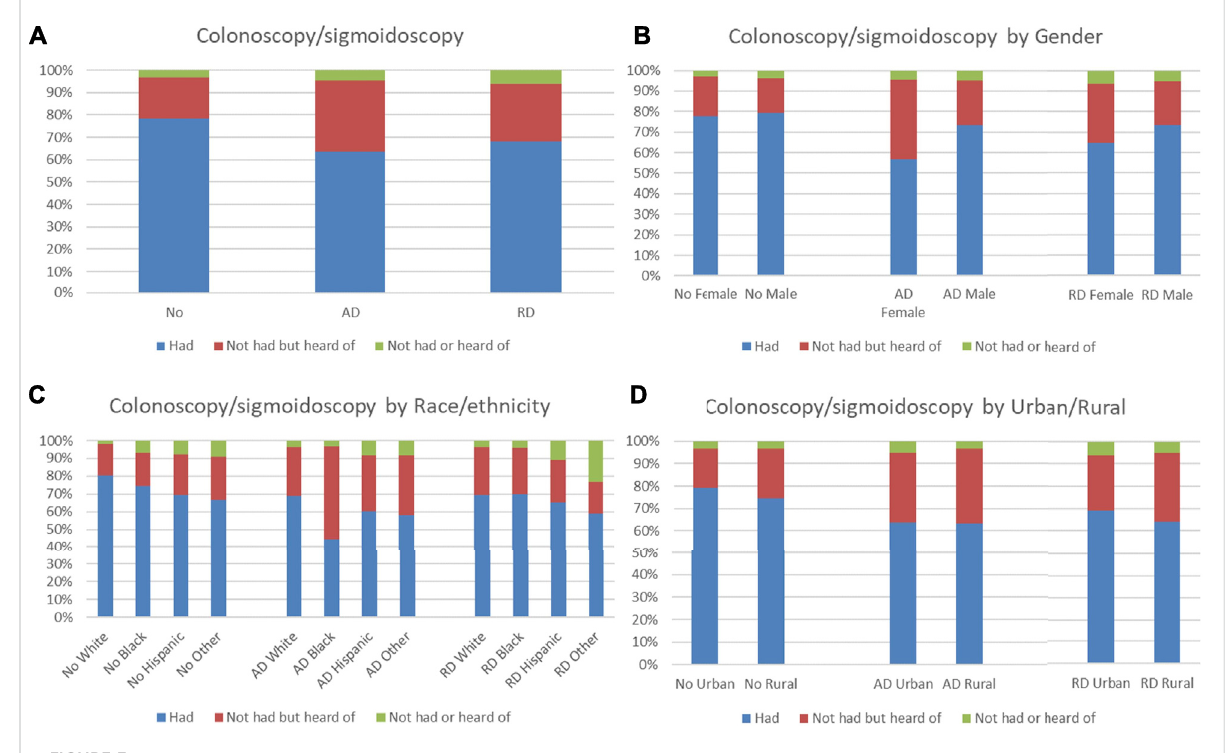
FIGURE 3 Distribution of colonoscopy/sigmoidoscopy use and knowledge by ADRD status (A) . Overall distribution; (B) . Distribution by gender; (C) . Distribution by race/ethnicity; (D) . Distribution by